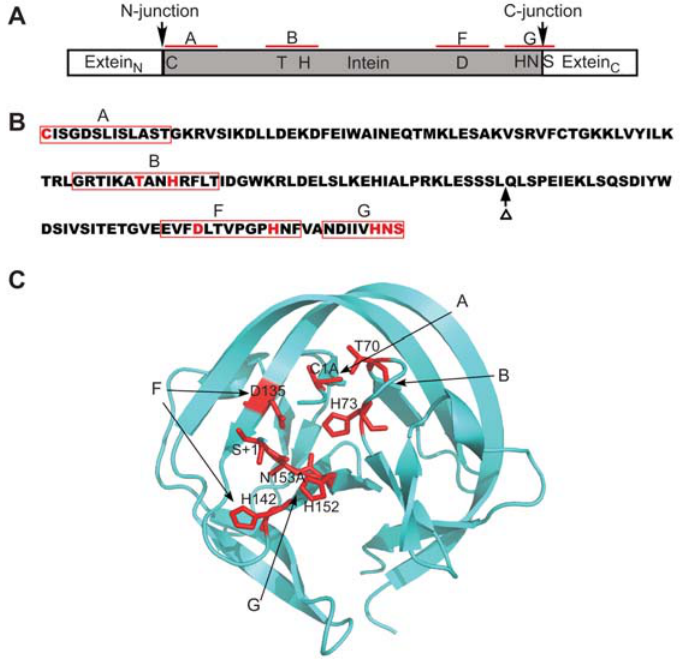
Figure 2 Conserved blocks in intein sequences. (A) Schematic view of an intein, the relative locations and lengths of sequence blocks/motifs A, B, F and G; highly conserved residues are indicated underneath the red motif bars. Variations in these residues are possible. (B) Amino acid sequence of the Ssp DnaB mini-intein with sequence blocks and conserved residues highlighted. The D symbol indicates the deletion point of the Ssp DnaB homing endonuclease domain. (C) Crystal structure of the Ssp DnaB mini-intein w PDB code: 1MI8; (117) x with the location of sequence blocks indicated by arrows and position of the conserved residues shown in B highlighted by red, ball-and-stick